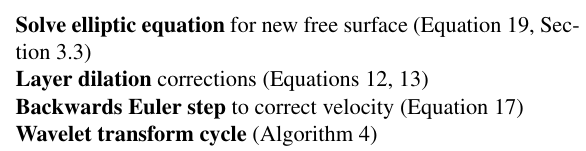
Algorithm 3 Implicit free surface